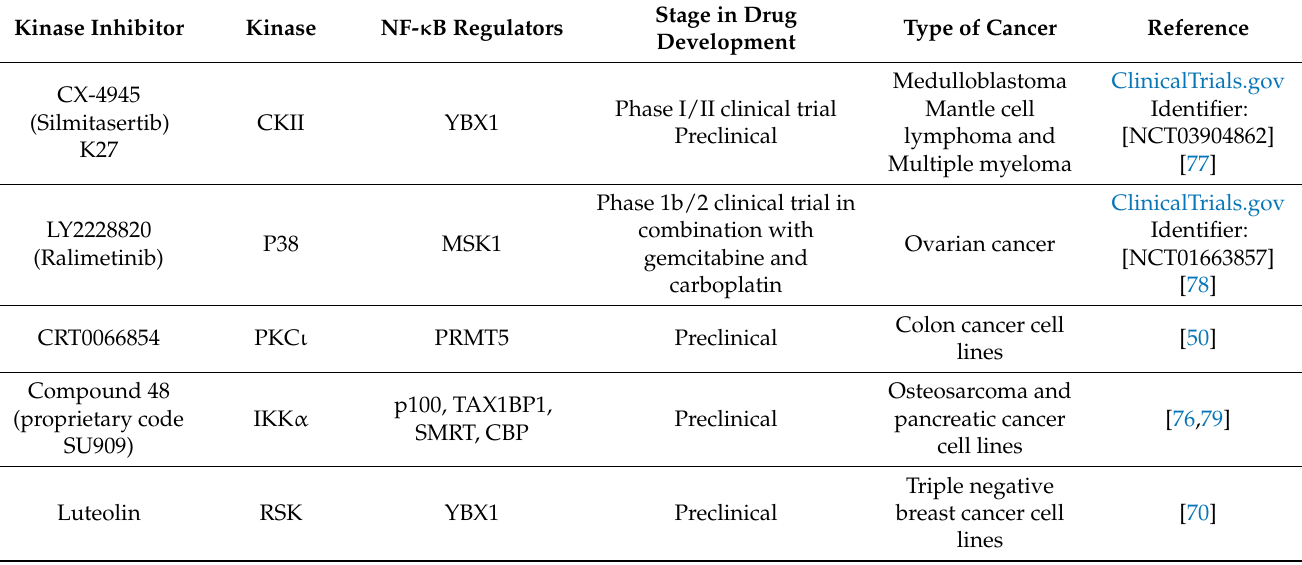
Table 2. Summary of some developed compounds targeting kinases that activate NF- κ B